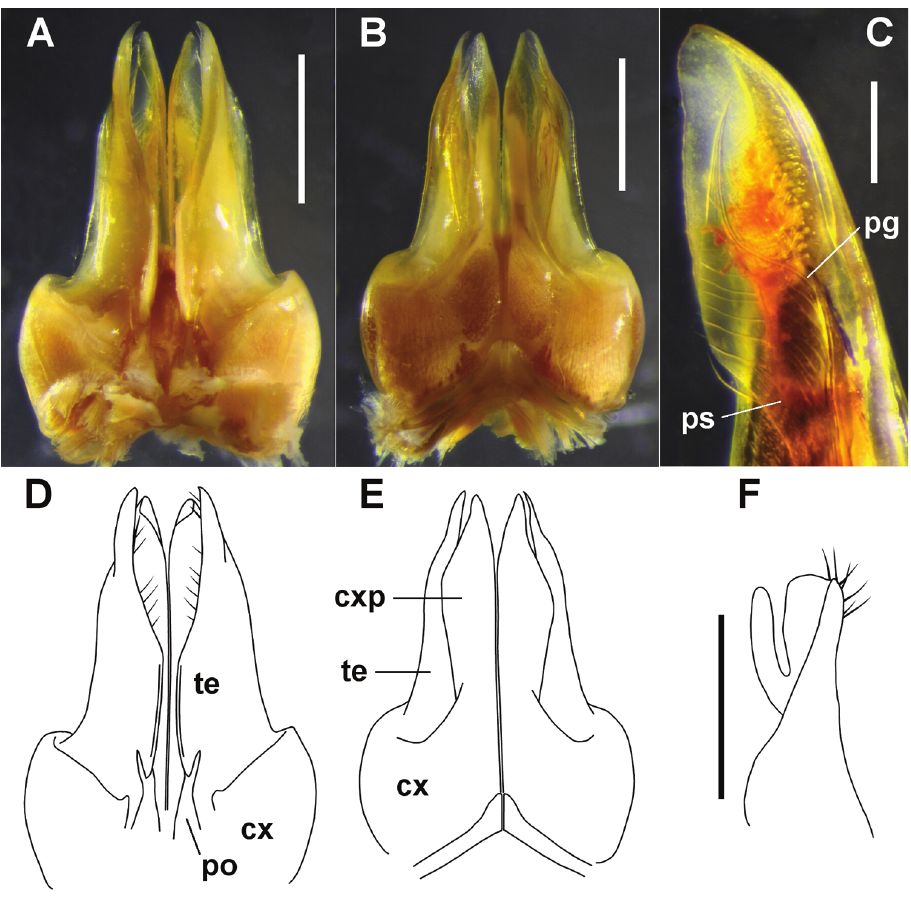
Figure 3. A, B, D, E Amastigogonus hardyi (Chamberlin, 1920) ex TMAG J5987. Posterior ( A, D ) and anterior ( B, E ) views of isolated gonopods, showing coxite (cx), coxite process (cxp) and telopo- dite (te) of anterior gonopod, and posterior gonopod (po) holding posteromedial flange of telopodite C Amastigogonus fossuliger Verhoeff, 1944, QVM 23:54356; anteromedial view of tip of anterior gonopod telopodite, showing transparent pseudoflagellum (ps) and prostatic groove (pg) F Amastigogonus tasmani- anus (Chamberlin, 1920) ex QVM 23:54344, isolated right posterior gonopod, medial view. Scale bars: A, B = 1.0 mm, C = 0.25 mm, F = 0.5